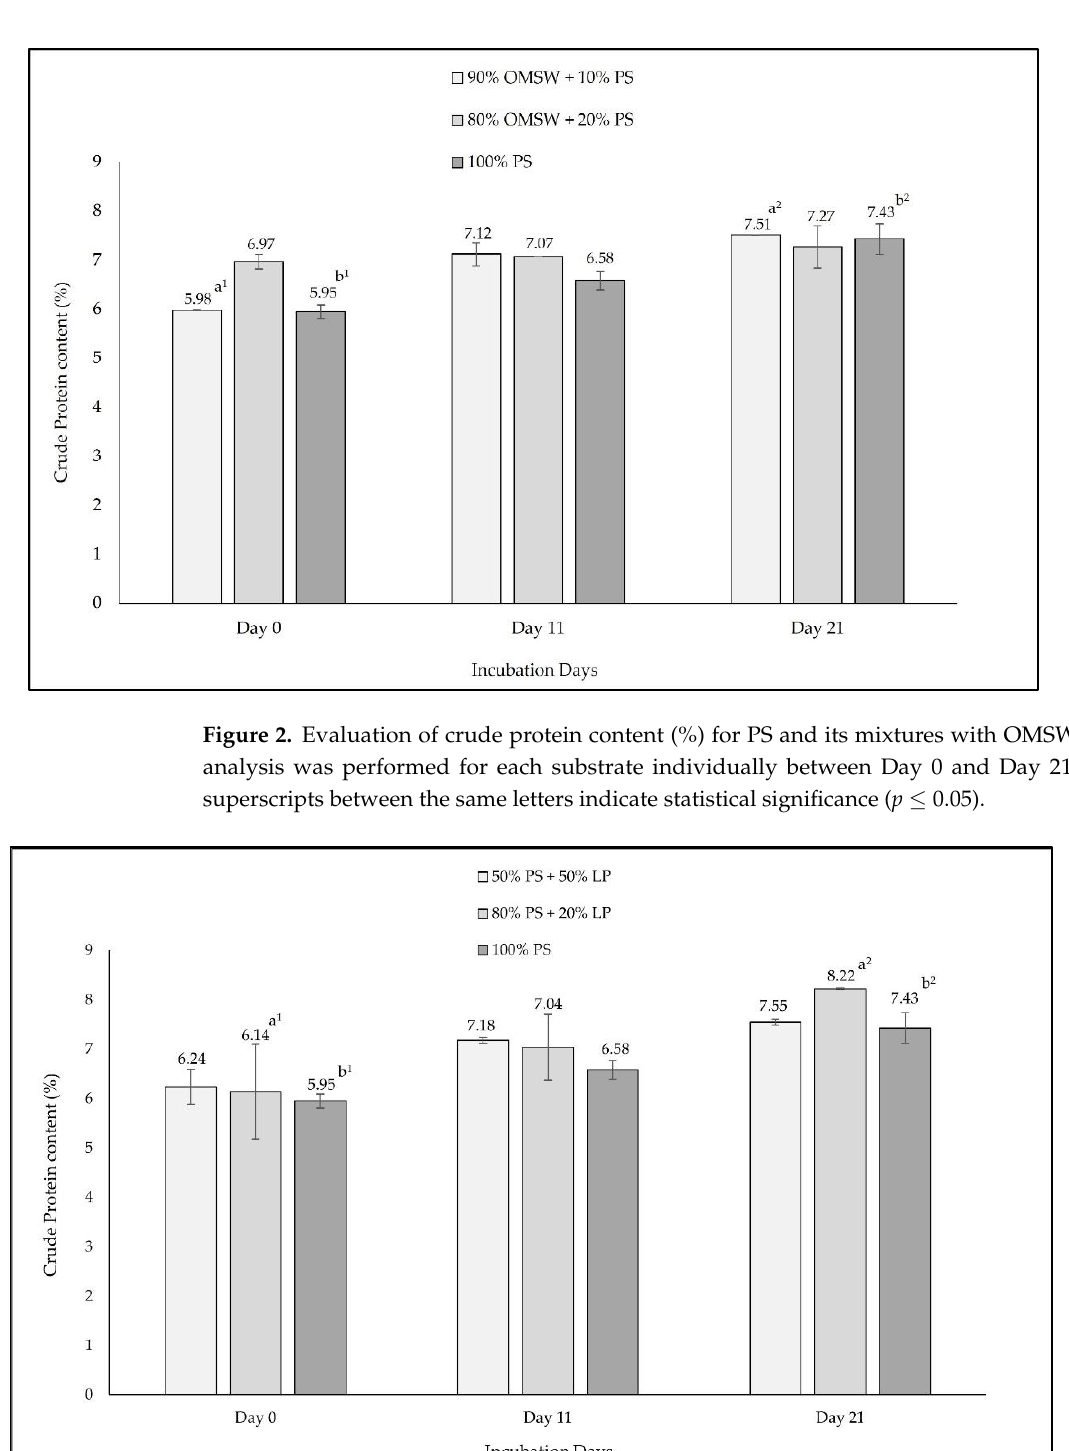
Figure 3. Evaluation of crude protein content (%) for PS and its mixtures with LPs. Statistical analysis was performed for each substrate individually between Day 0 and Day 21. Different superscripts between the same letters indicate statistical significance ( p ≤ 0.05).